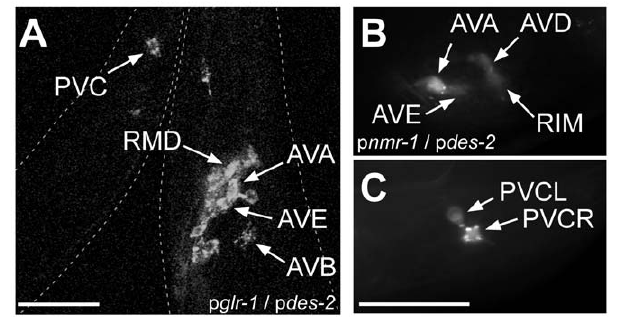
Figure 2. Promoter combinations chosen for expression of ChR2 in PVC neurons, using Cre recombinase, are not PVC- specific. A ) Confocal stack of an animal expressing ChR2::mCherry in head neurons and PVC, using the glr-1 and des-2 promoters, resembling the p glr-1 expression pattern. B ) The promoter combination nmr-1 and des-2 led to an expression in four neurons in the head (AVA, AVB, AVD, AVE), in addition to expression in PVC in the tail ( C ). Scale bars=20 m m.